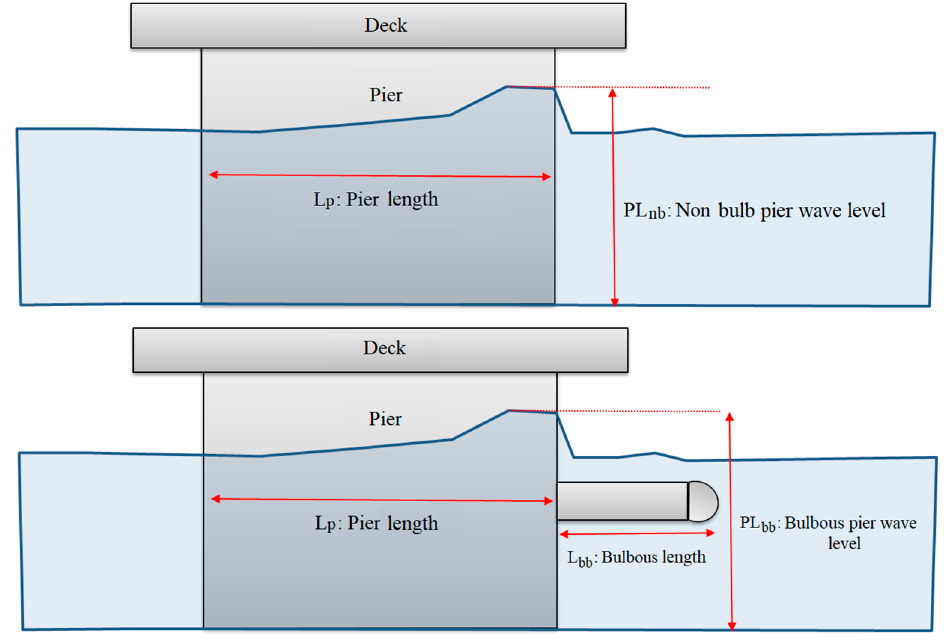
Figure 4. Pier with and without a bulb.